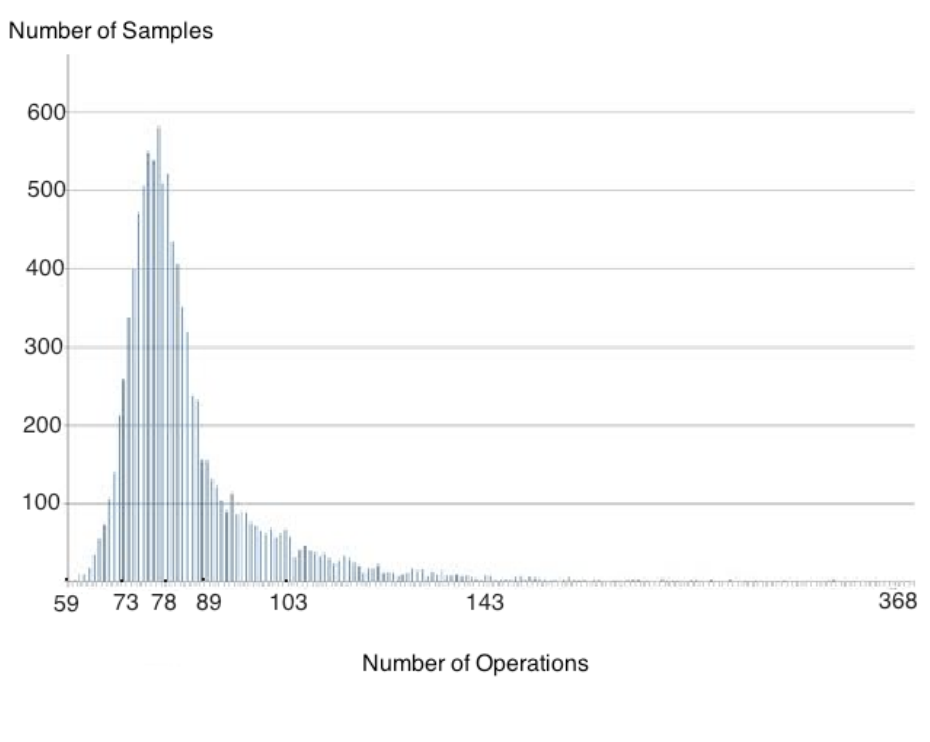
Figure 3. Distribution at the output of zChaff running problems with n = 50 and m = 150 , m = 3 n